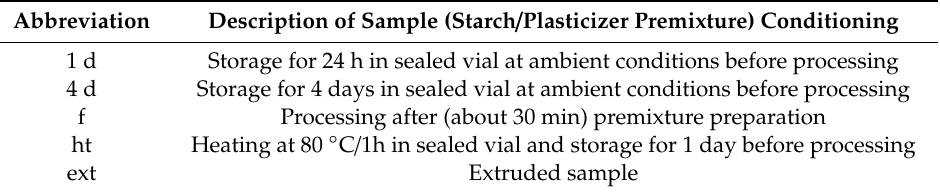
Table 1. Description of abbreviations used with samples